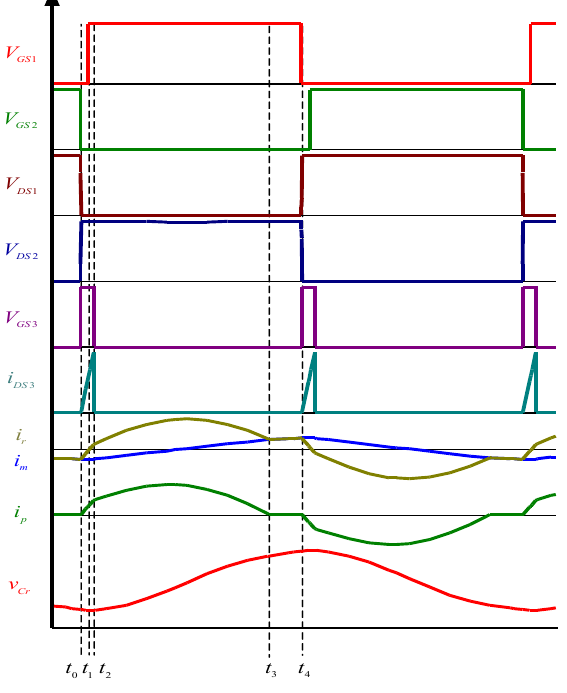
Figure 13. Main waveforms of novel LLC control